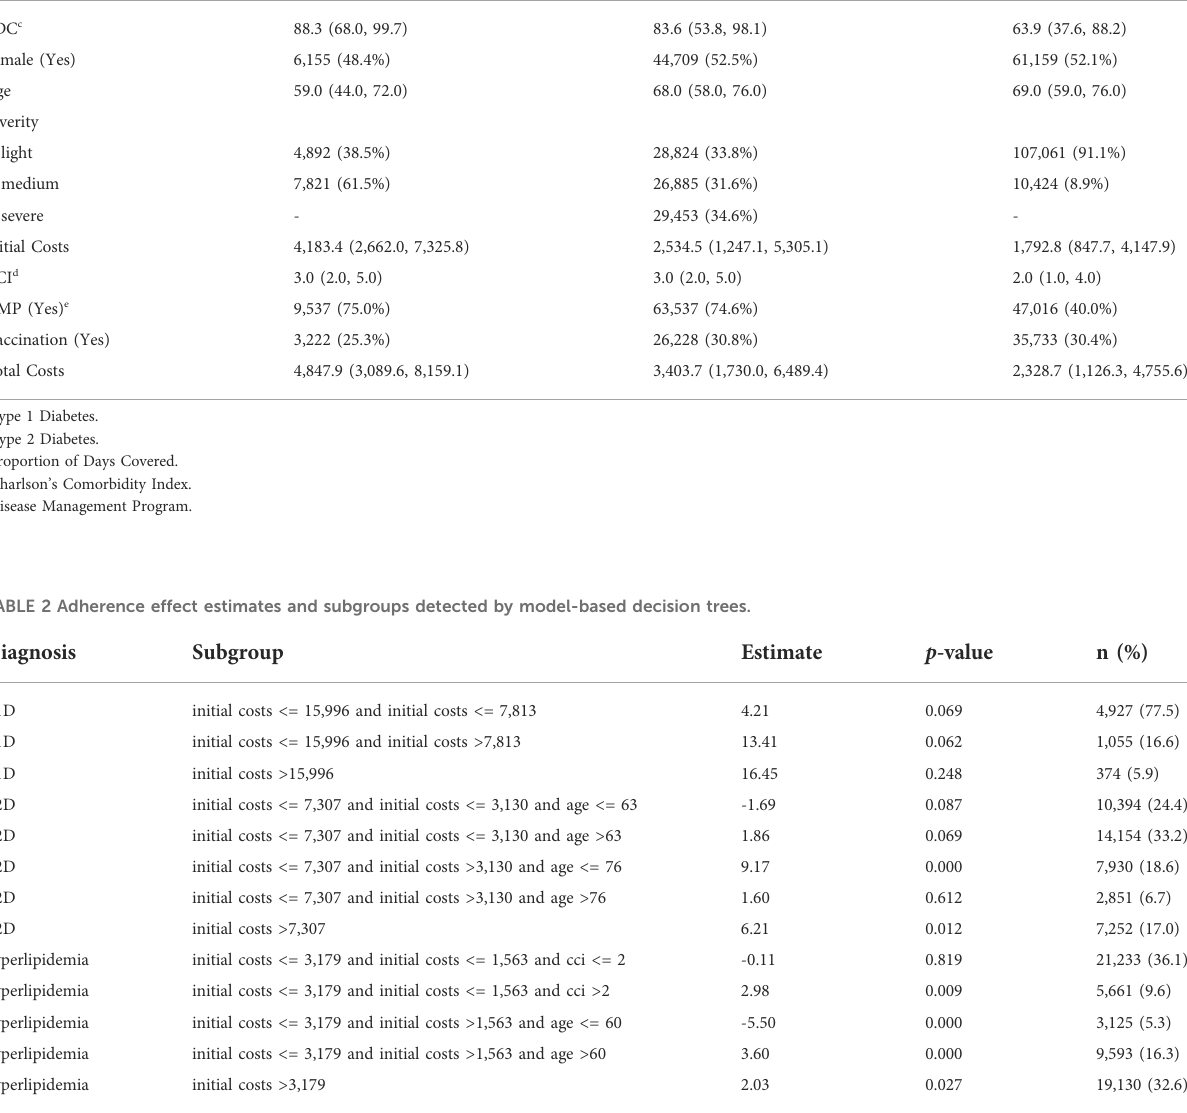
TABLE 1 Descriptive summary statistics of cohorts of 3 chronic diseases: Median (IQR) for continuous and absolute (relative) frequencies for categorical variables. Variable